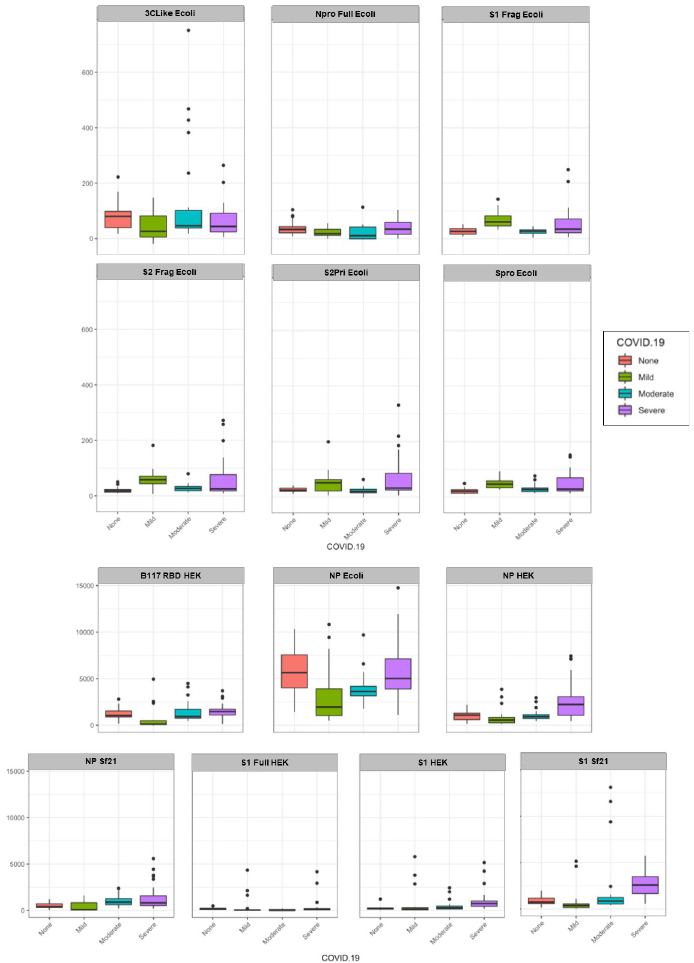
Fig 3. Serum IgG samples by COVID-19 disease severity (mild, moderate, severe) binding to the various SARS-CoV-2 protein antigens compared to no disease (NC). Each antigen was plotted using a boxplot with relative fluorescence intensity of binding on the y-axis and COVID-19 disease cohort on the x-axis.